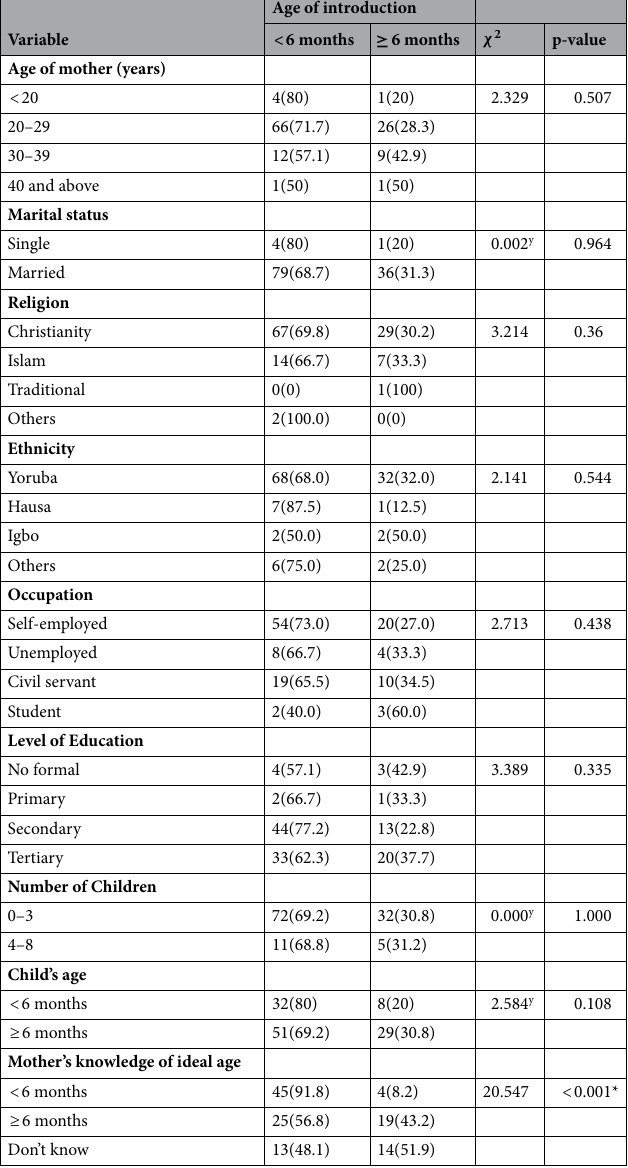
square test; y : Yates correction; *: p-value <